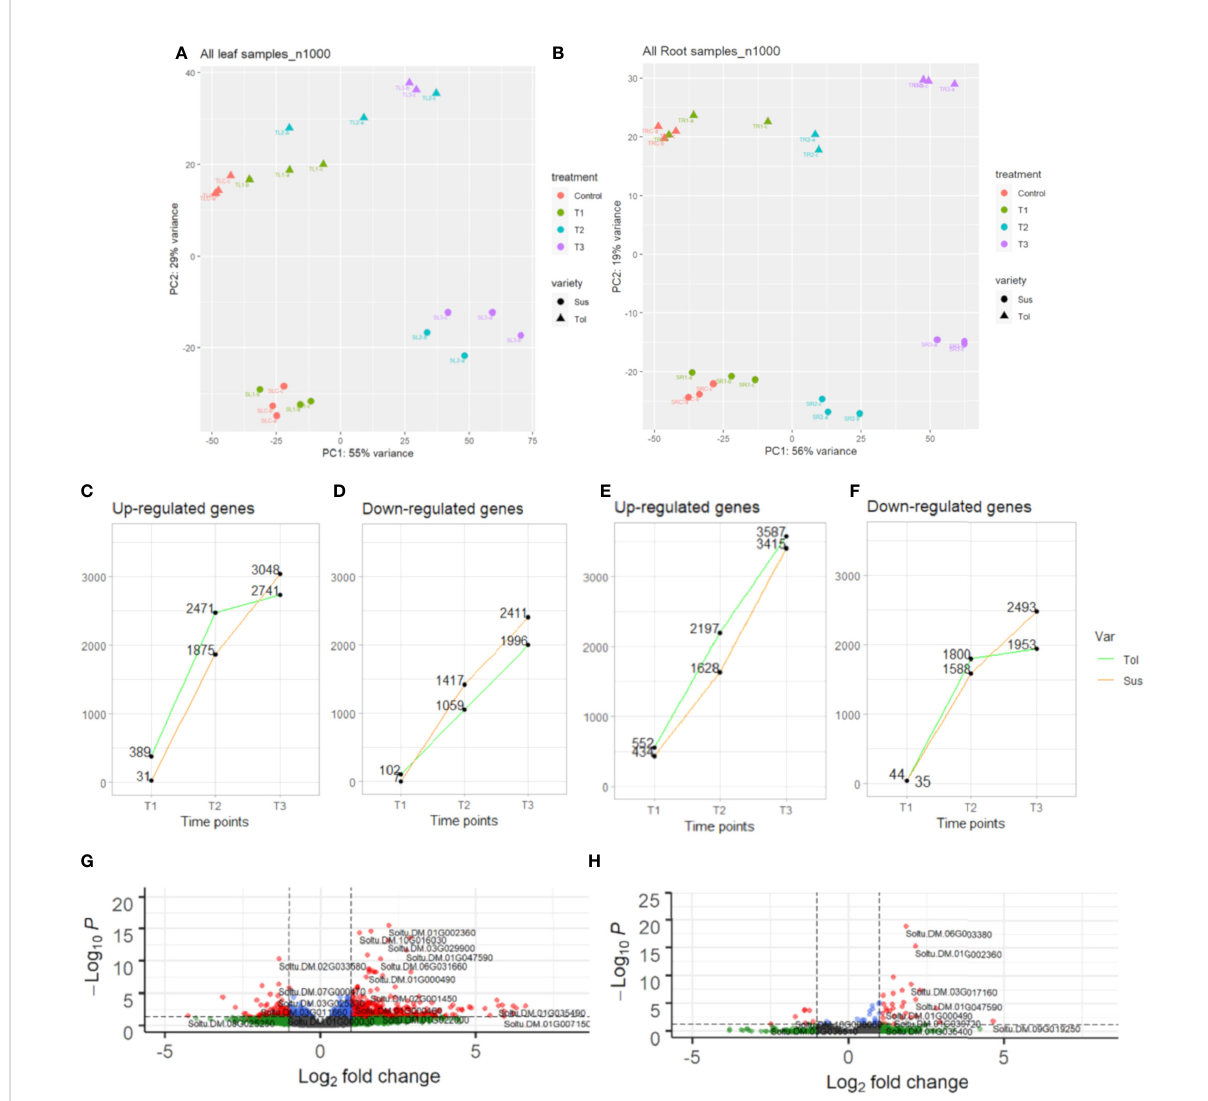
FIGURE 1 Transcriptomic overview of progressive drought response in two potato varieties. Principal component analysis (PCA) of leaf (A) and root (B) in tolerant (Tol) and susceptible (Sus) varieties in the non-stressed control and across three drought-stressed time points (early T1, late T2 and recovery after rewatering T3). The number of DEGs in each time point compared with the non-stressed control that are up-regulated in leaf (C) or root (E) or downregulated in leaf (D) or root (F) . Volcano plot showing differential expression of genes in T1 in leaf (G) or root (H) compared with the control. Vertical dashed lines indicate absolute log2FC ≥ 2. Horizontal dashed lines indicate padj. equal to 5%. Genes passing neither threshold are shown in grey, while non-signi fi cant genes passing the FC threshold are shown in green. In blue are genes with a small but signi fi cant fold change and in red are genes passing both